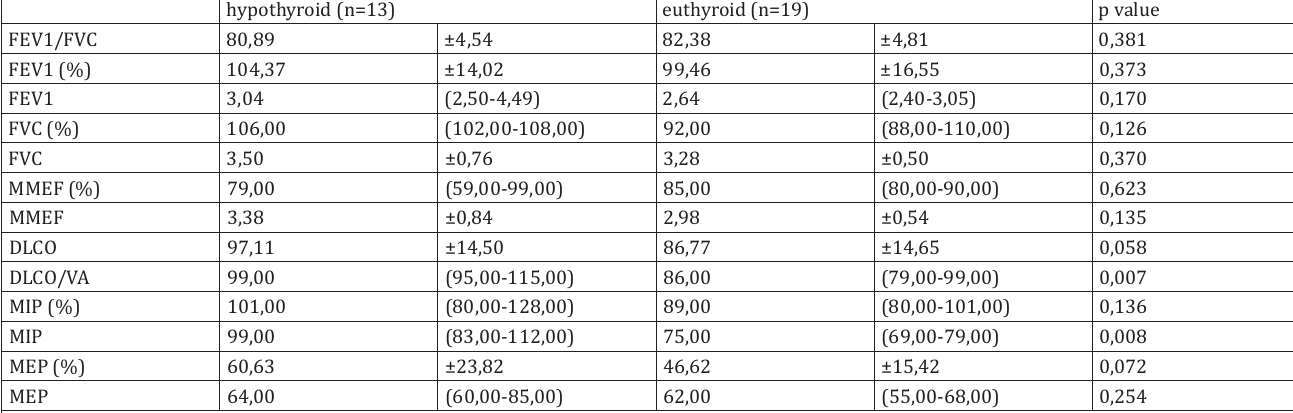
Comparison of the MIP, MEP and pulmonary function tests of the patients according to the groups